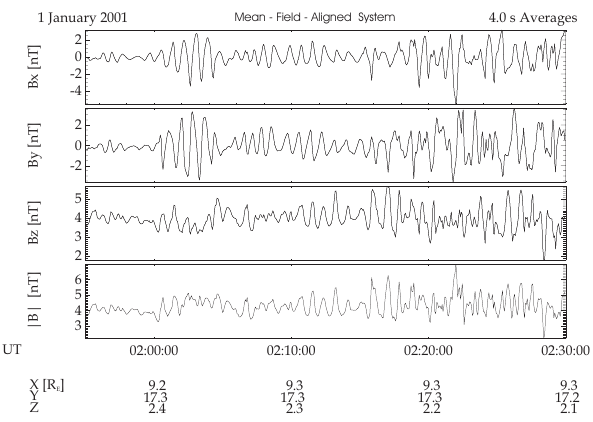
Fig. 4. Magnetic field observations recorded by Cluster 1 in the interval on 1 January 2001, 01:55–02:30UT. The data are displayed in a mean field-aligned coordinate system with the B Z direction aligned with the mean magnetic field direction.